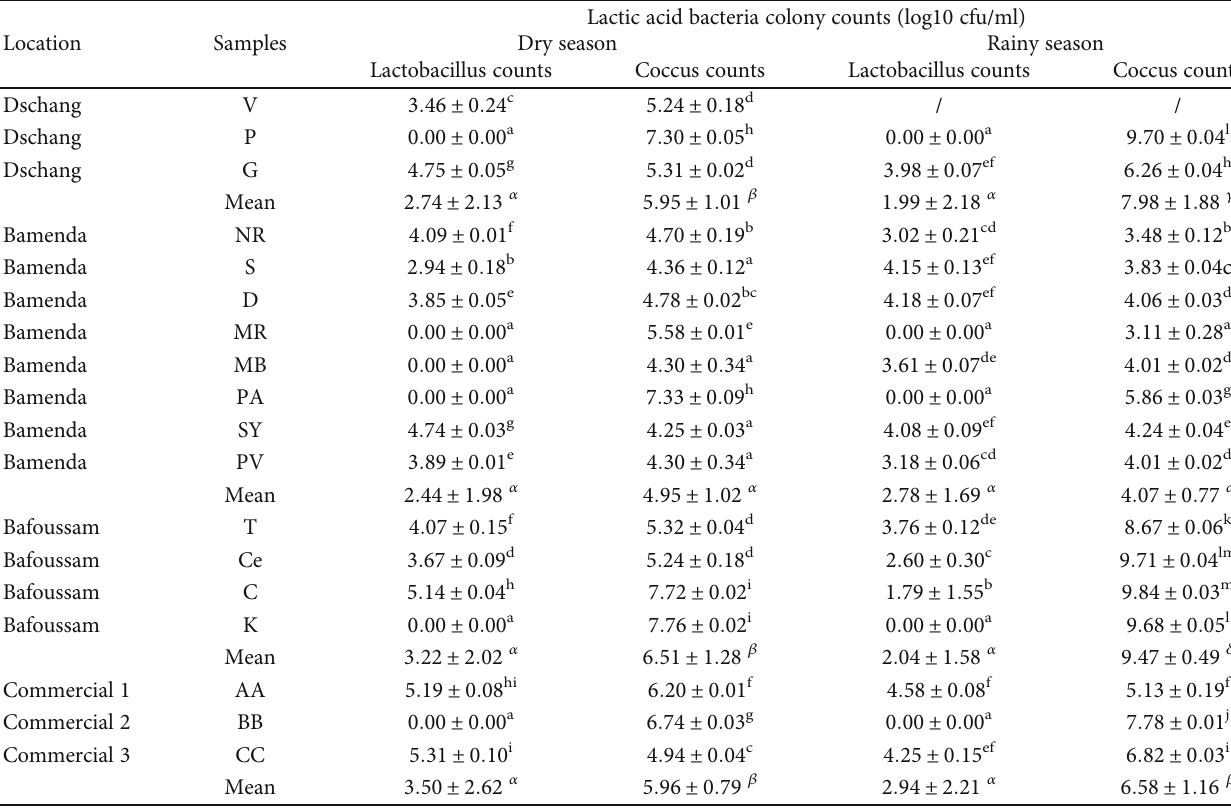
Table 1: Lactic acid bacteria counts of yoghurt during the dry and rainy seasons as a function of place of production and sample. Location